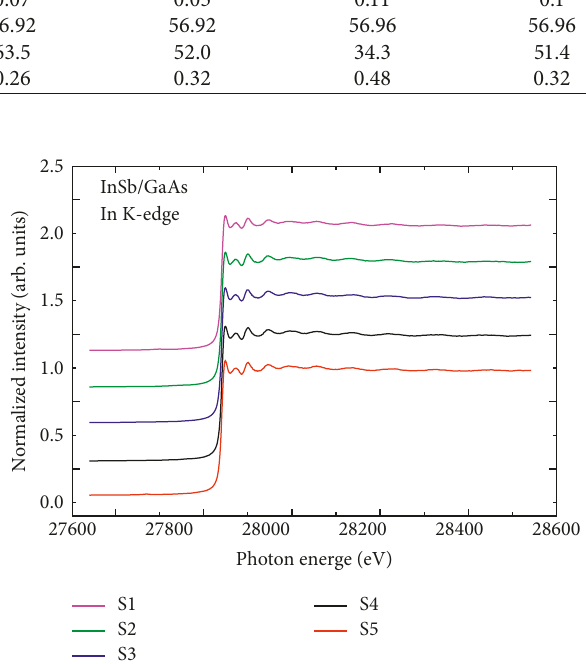
Figure 3: X-ray absorption spectra of In-K edge (27,940 eV) for five InSb